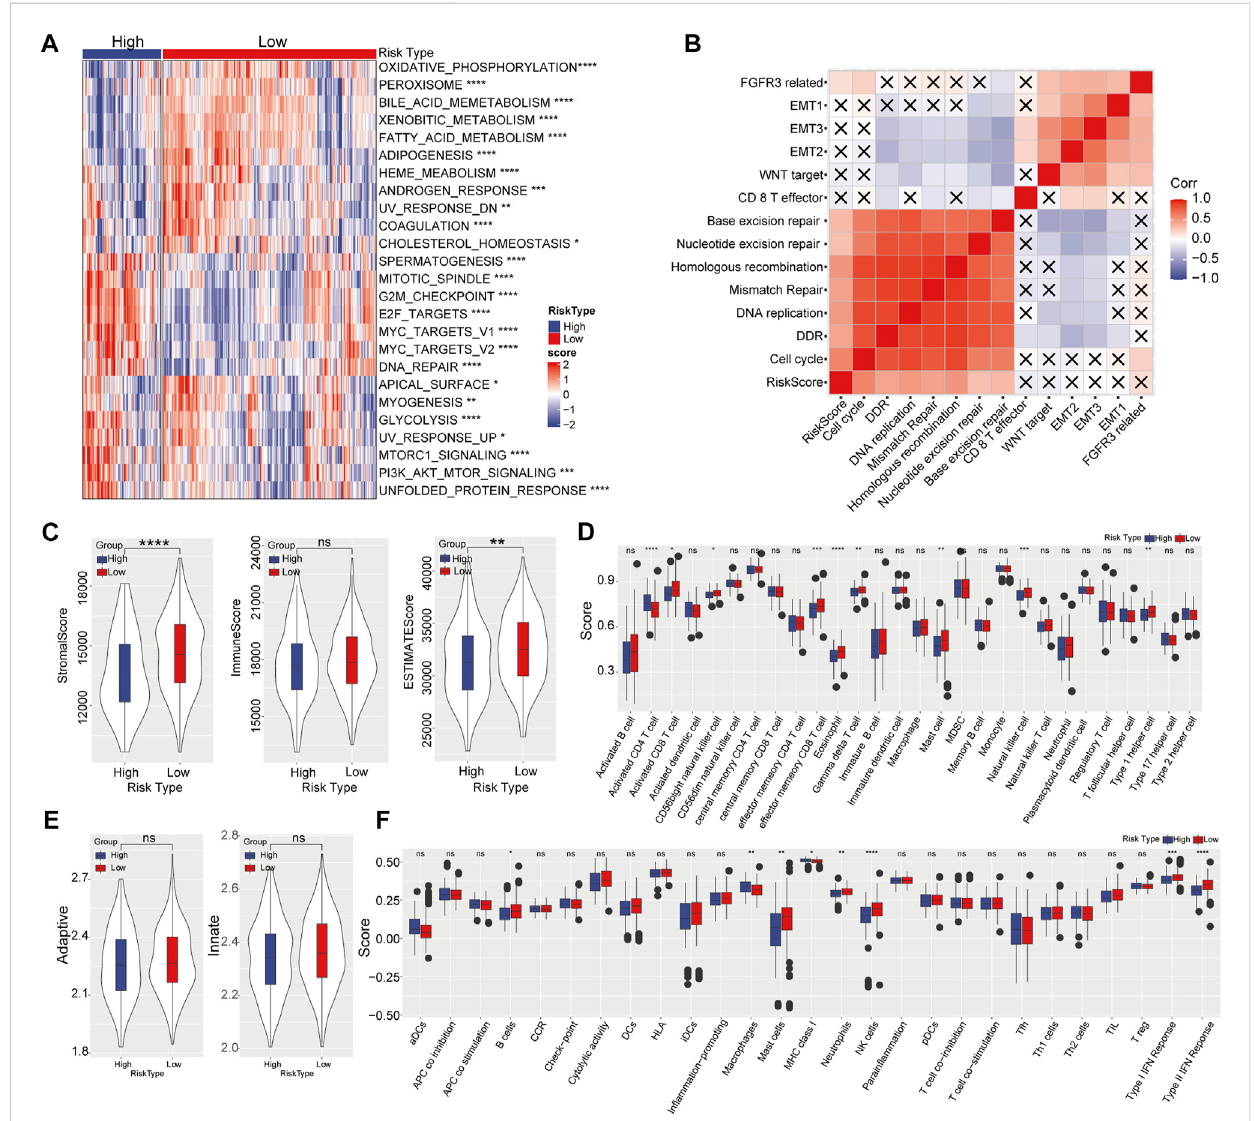
FIGURE 5 Effect of prognostic risk model on immune in fi ltration. (A) Enrichment heatmap of biological pathways in high- and low-risk categories. (B) Correlation analysis between risk score and biological process. (C) Stromal score, immune score, and ESTIMATE score in high-risk and low-risk categories. (D) The enrichment scores of 28 immune cells in high- and low-risk groups. (E) The adaptive and innate immune status in two risk groups. (F) The enrichment scores of 29 immune signature in high- and low-risk